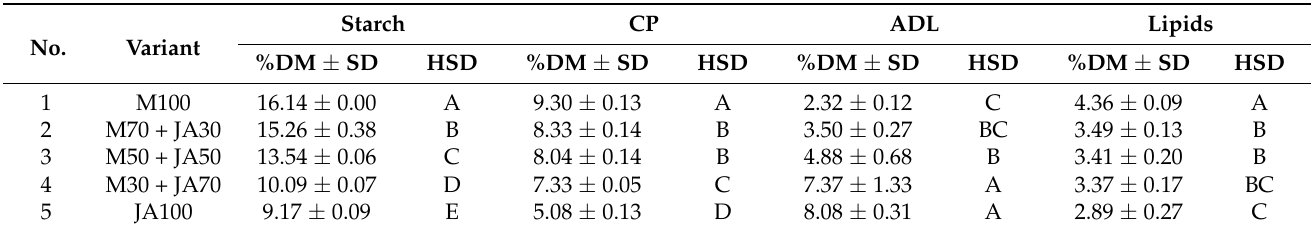
Table 6. Contents of starch, CP, ADL and lipids in the prepared model silages.